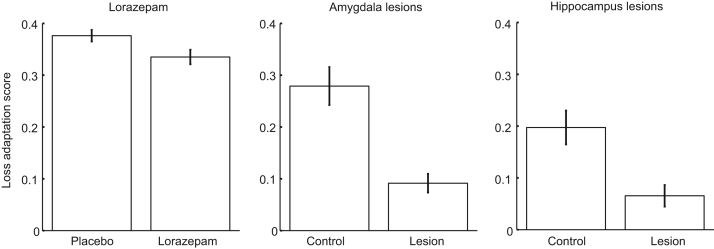
Loss adaptation scores in the approach–avoidance paradigm. Loss adaptation in the game is reduced under lorazepam vs. placebo and in two patients with amygdala lesions vs. healthy control participants. This mirrors reductions of loss adaptation in patients with hippocampus lesions [reanalyzed from (15)]. The loss adaptation score combines the seven behavioral metrics of the approach–avoidance conflict paradigm (see Figures 2 and 3 and Supplemental Figures S1 and S2). The overall differences in loss adaptation scores among the three groups are likely due to age differences (mean ± SD of the three samples in years: lorazepam study: 25.1 ± 4.4; amygdala lesions study: 40.2 ± 3.0; hippocampus lesions study: 44.0 ± 9.3). As a side finding, we observed that loss adaptation score correlated negatively with age across the three control groups (Pearson’s r = −.41, p = .0013). Error bars depict standard errors of the mean.